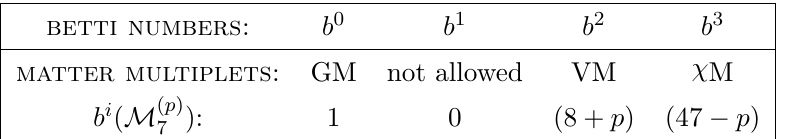
Table 5 . The explicit relation between the topological data of a smooth G matter content of the e(cid:11)ective 4D description. The actual values of the Betti numbers in the last line refer to the inequivalent smoothing procedures labeled by the integer p